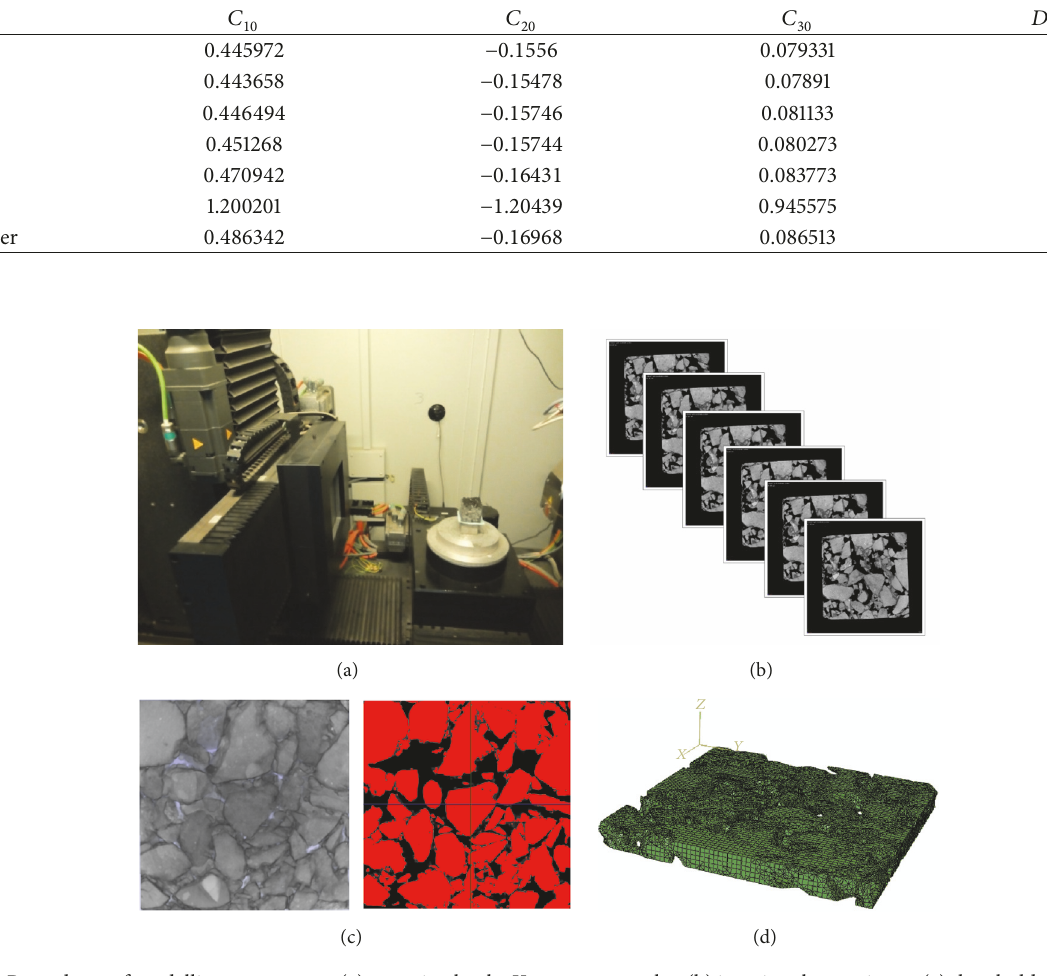
Figure 5: Procedures of modelling a pavement: (a) scanning by the X-ray tomography; (b) imaging the specimen; (c) threshold segmentation of the images; (d) FE model.